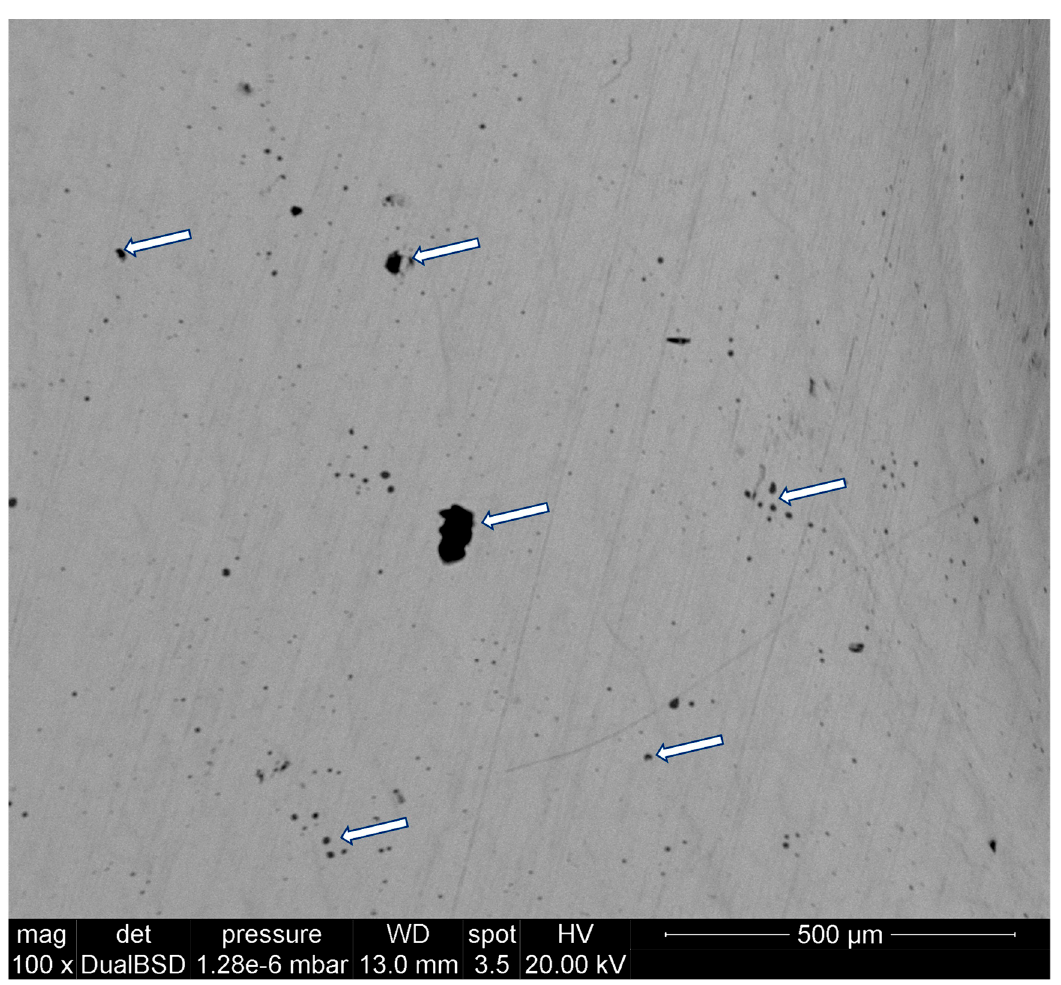
Figure 1. Porosity distribution in AISI 316L manufactured using binder jetting.